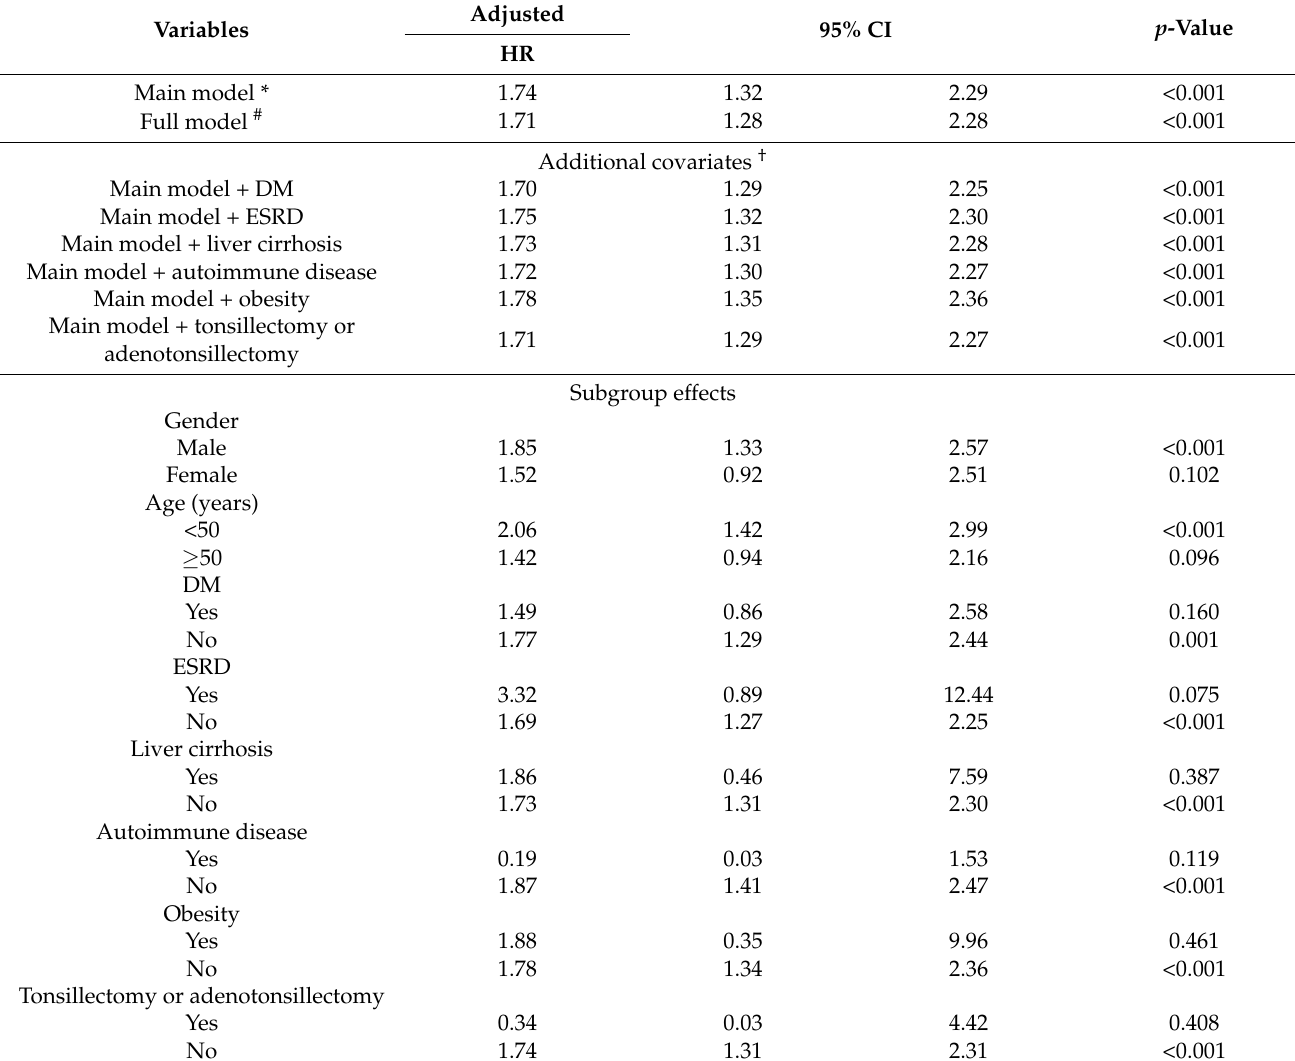
Table 2. Multivariable Cox proportional hazard model of sleep apnea and DNI